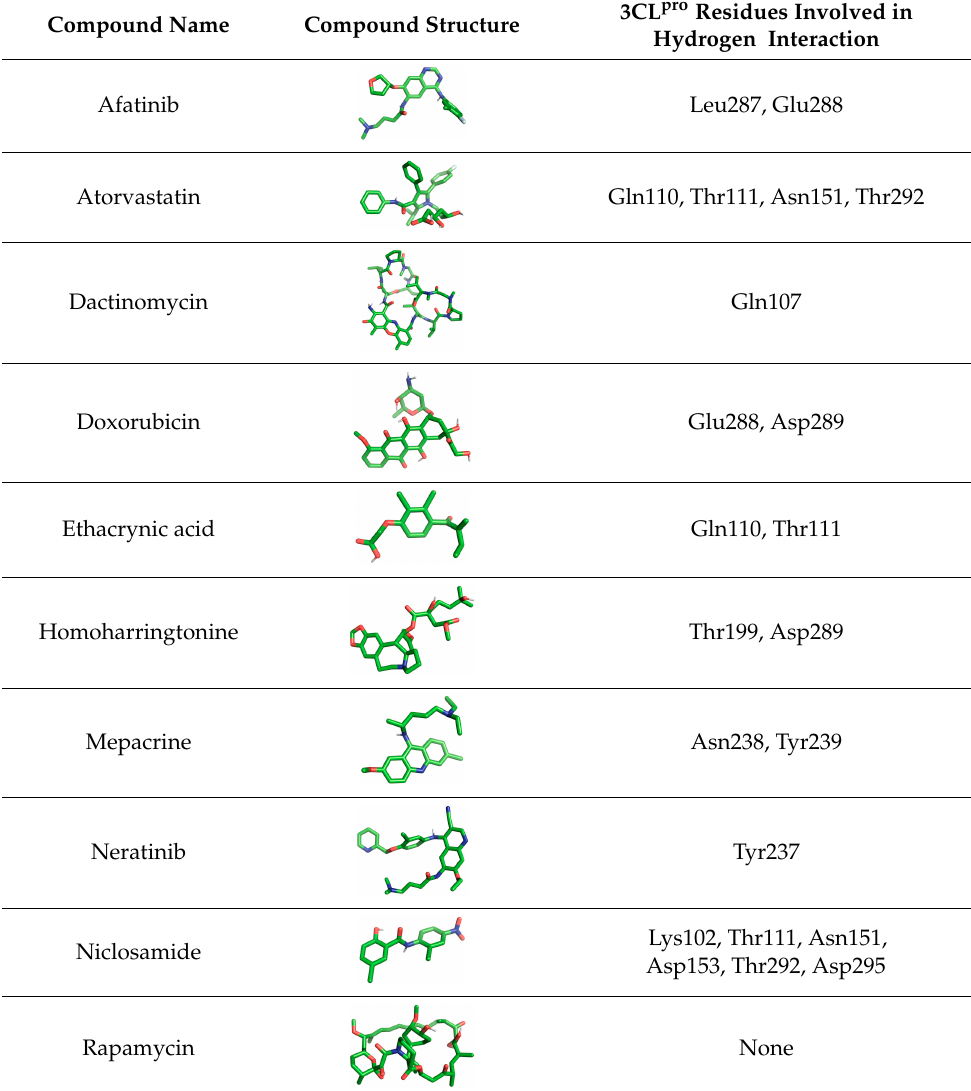
Table 2. Docking affinity for PL pro and molecular structure of individual compounds.